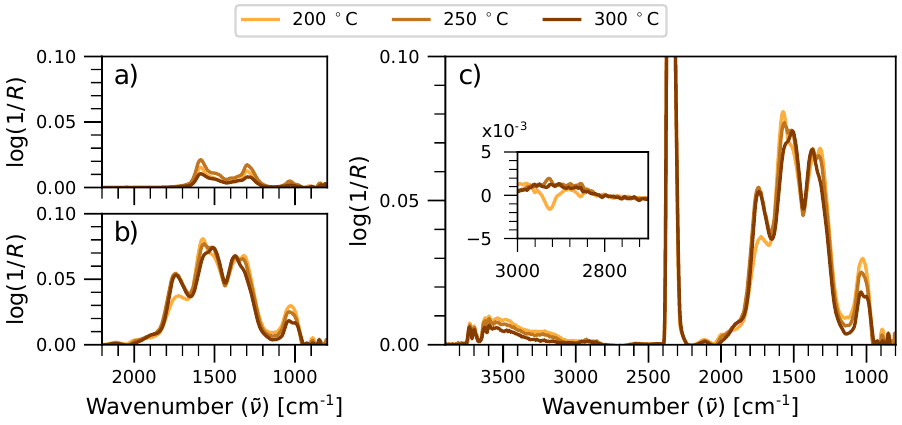
Figure 1. Steady-state in situ infrared spectra for a Rh/CeO 2 catalyst at different temperatures in the C–O bond region 2200–800 cm − 1 during ( a ) CO 2 adsorption and ( b ) hydrogenation and in the full measured region with a zoom at the C–H bond region 3000–2550 cm − 1 during hydrogenation ( c